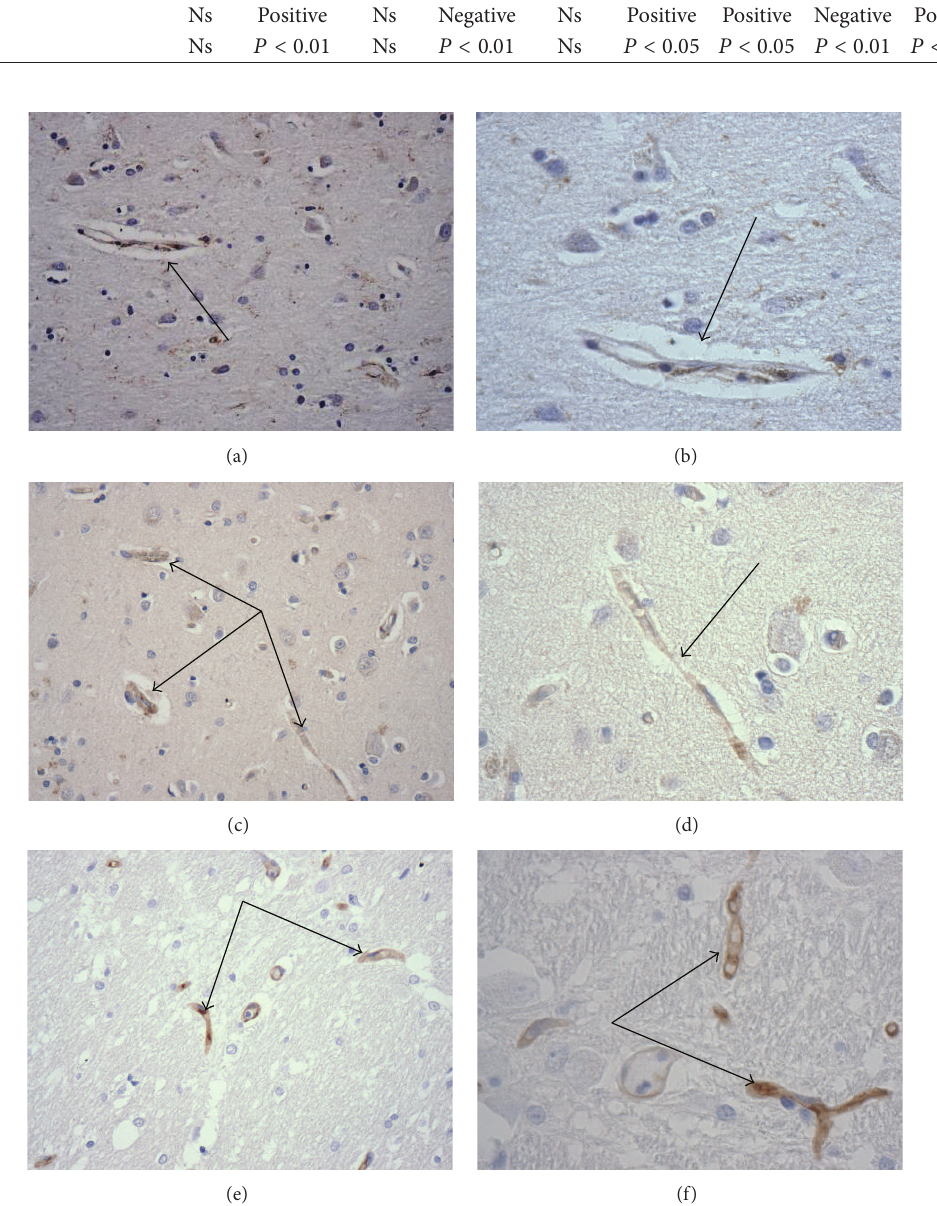
Figure 2: Immunohistochemical illustrations (arrows) of blood-brain barrier endothelial cell associated amyloid transport proteins. Immunohistochemical staining for (a and b) LRP, × 200 & × 400, respectively; (c and d) RAGE, × 200 & × 400, respectively; (e and f) P-gp, × 200 & × 400,